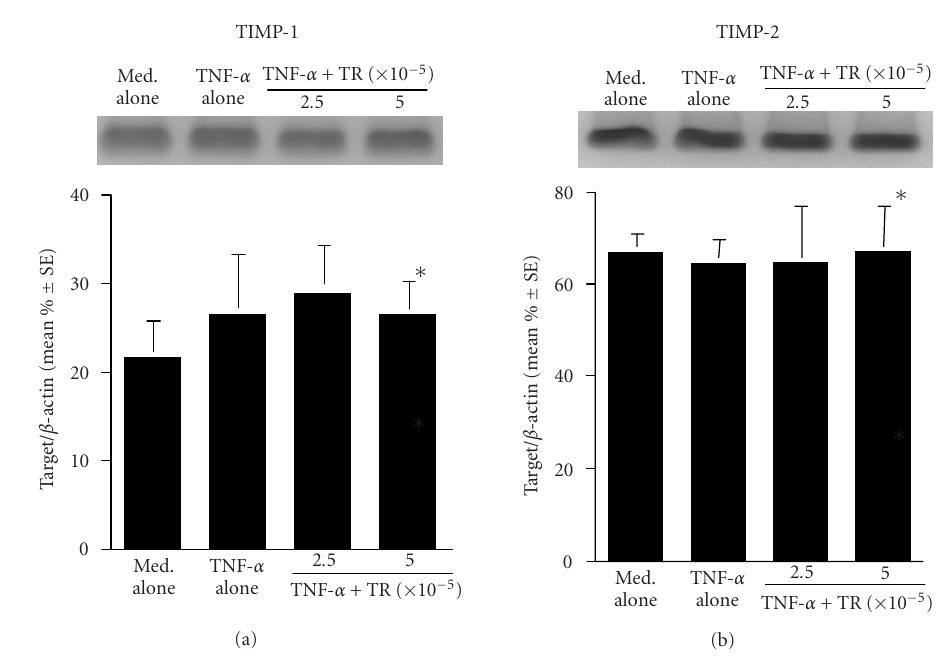
Figure 7. Influence of tranilast (TR) on mRNA expression of TIMP-1 and TIMP-2 in nasal polyp fibroblasts after TNF- α stimulation. Cells were stimulated with 10 . 0 ng/mL TNF- α in the presence of various concentrations of TR for 12 hours. mRNA expression was examined by RT-PCR. One representative photograph out of five di ff erent subjects is shown. Densitometric analysis of the results of RT-PCR is shown with the intensity of MMP-2 and MMP-9. β -actin mRNA expression was shown in Figure 6. ∗ means not significant ( P < . 05) compared with TNF- α